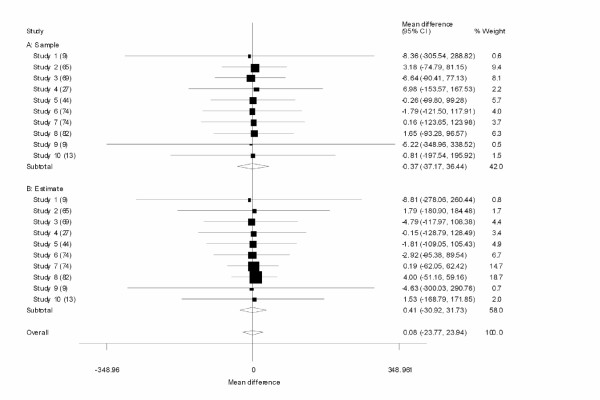
Meta-Analysis of random data. After drawing fifteen samples of random sizes (between 8 and 100) from the Log-Normal [4, 0.3] distribution, we used our estimation formulas to estimate the mean and the variance from the median and the range. Then we performed meta-analysis using STATA, treating the real samples as one subgroup and their estimates as another subgroup to determine the results and heterogeneity.